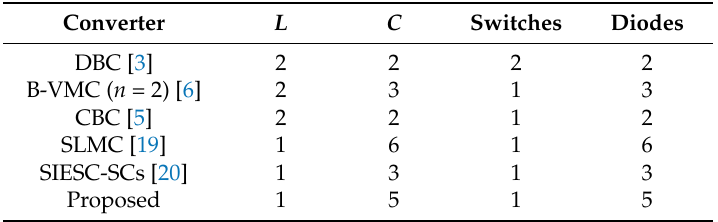
Table 3. Comparison of topologies.